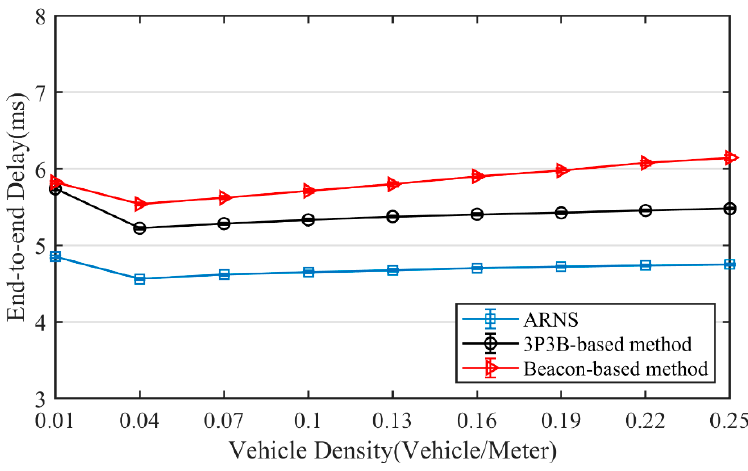
Figure 4. End-to-end delay.